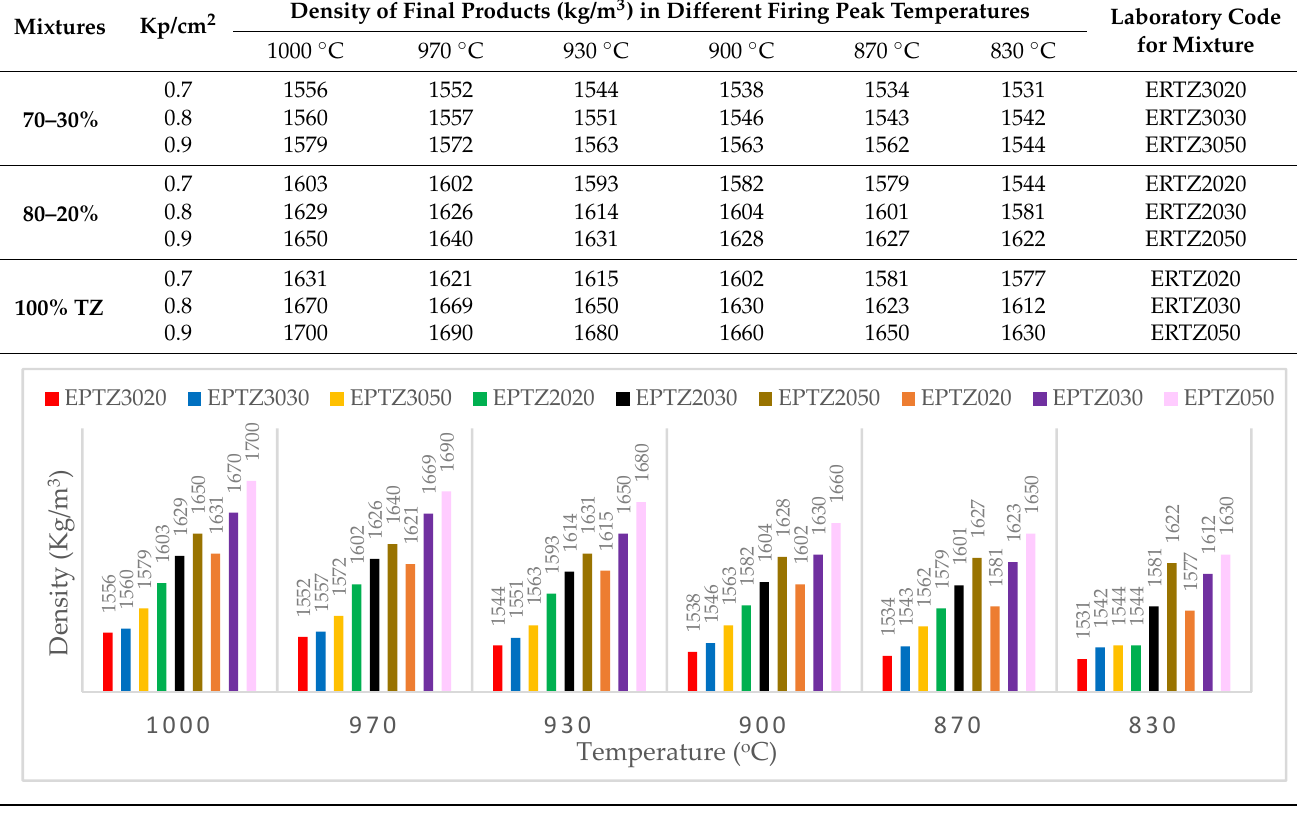
Table 8. Absorption for all constructed mixtures at 6 different temperatures.